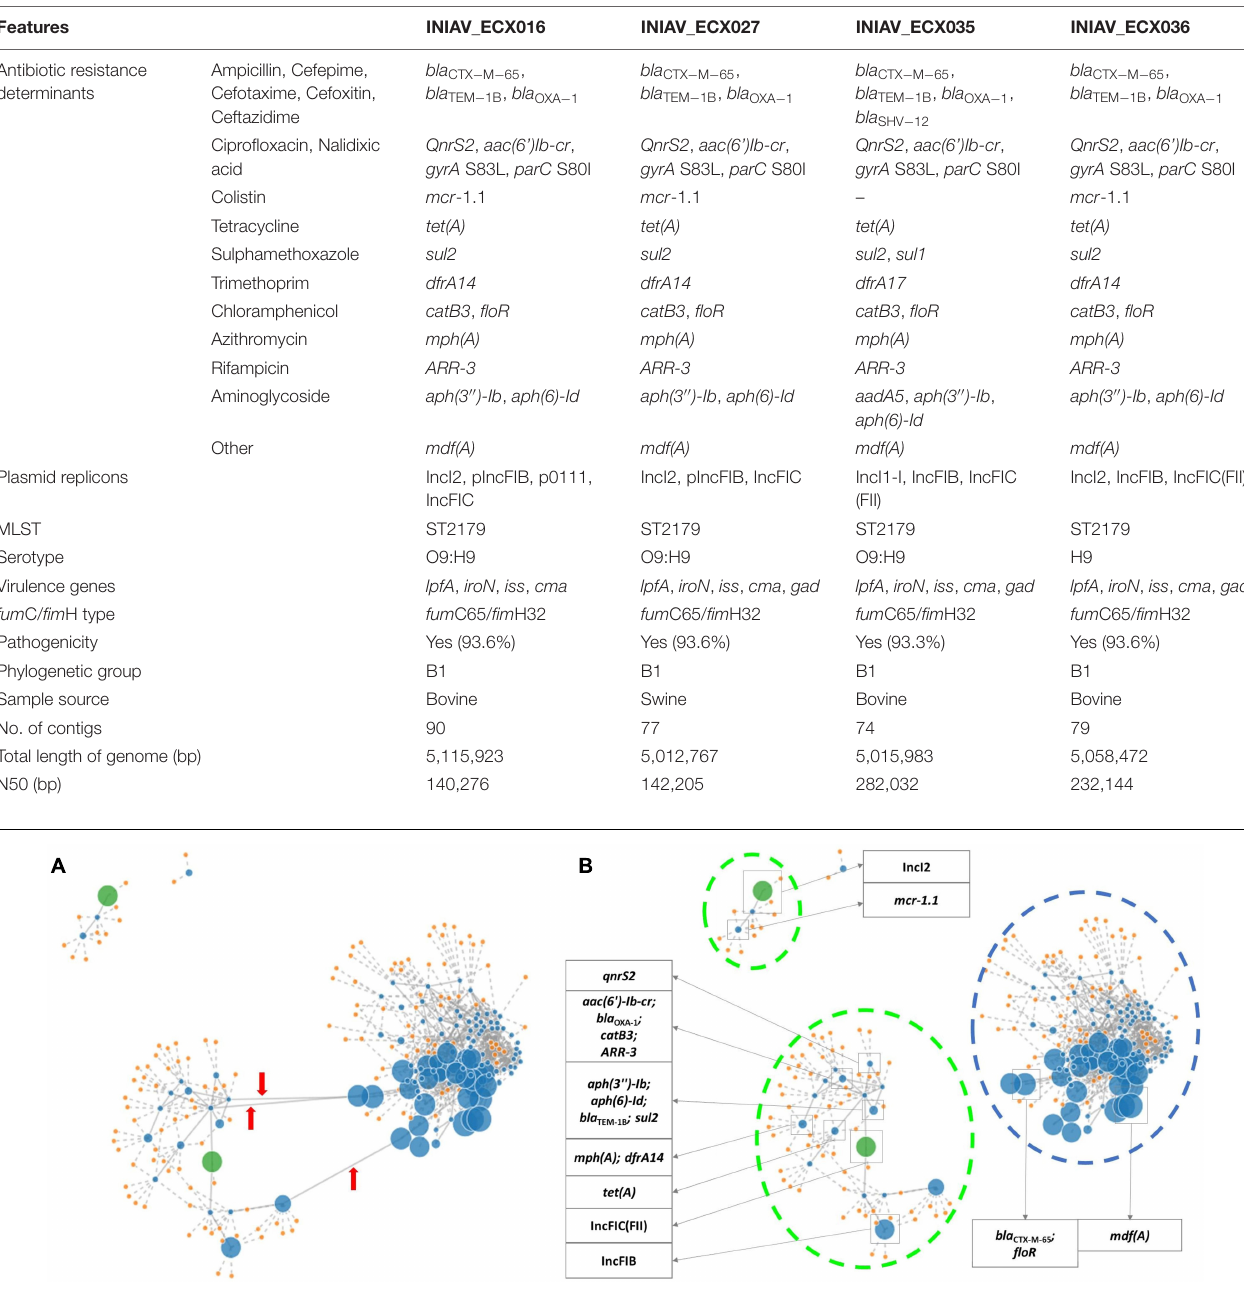
TABLE 2 | Genomic characterization of the four CTX-M-65-producing E. coli isolates by whole-genome sequencing. Features